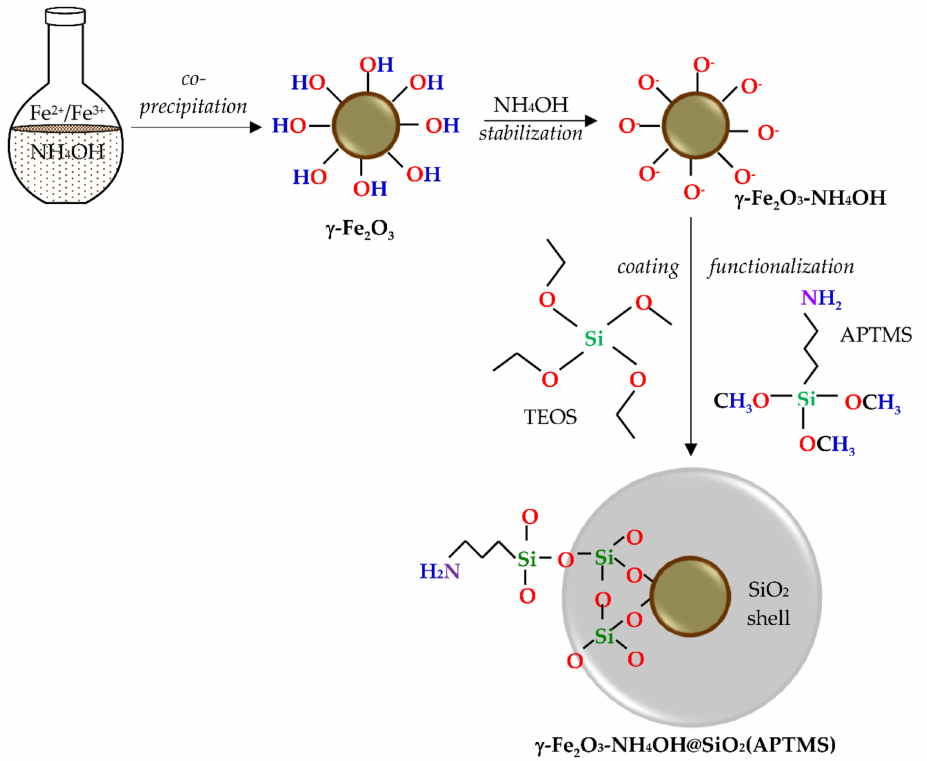
Figure 1. Magnetic γ -Fe 2 O 3 -NH 4 OH@SiO 2 (APTMS) nanoparticles